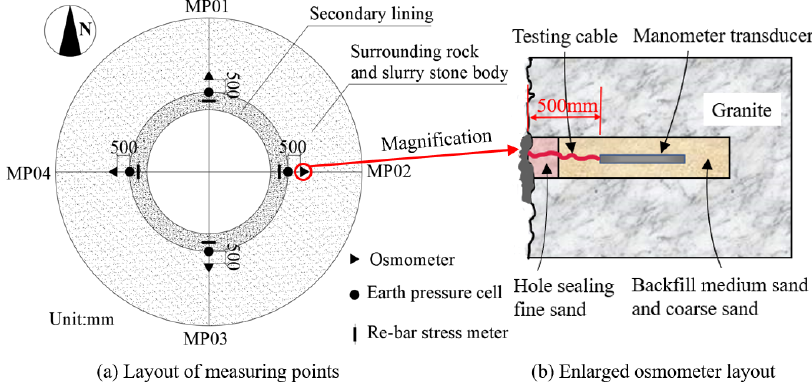
Figure 7. Layout of measuring points and piezometers.